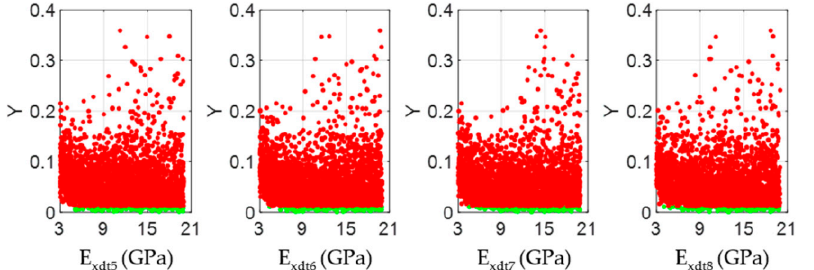
Figure 15. Scatter plots of the output samples (Y function) against the four input factors located in the central third of the timber board # 19 ( E xdt in zones 5 to 8). The green and red dots represent the sets B (behavioral) and NB (non-behavioral), respectively.